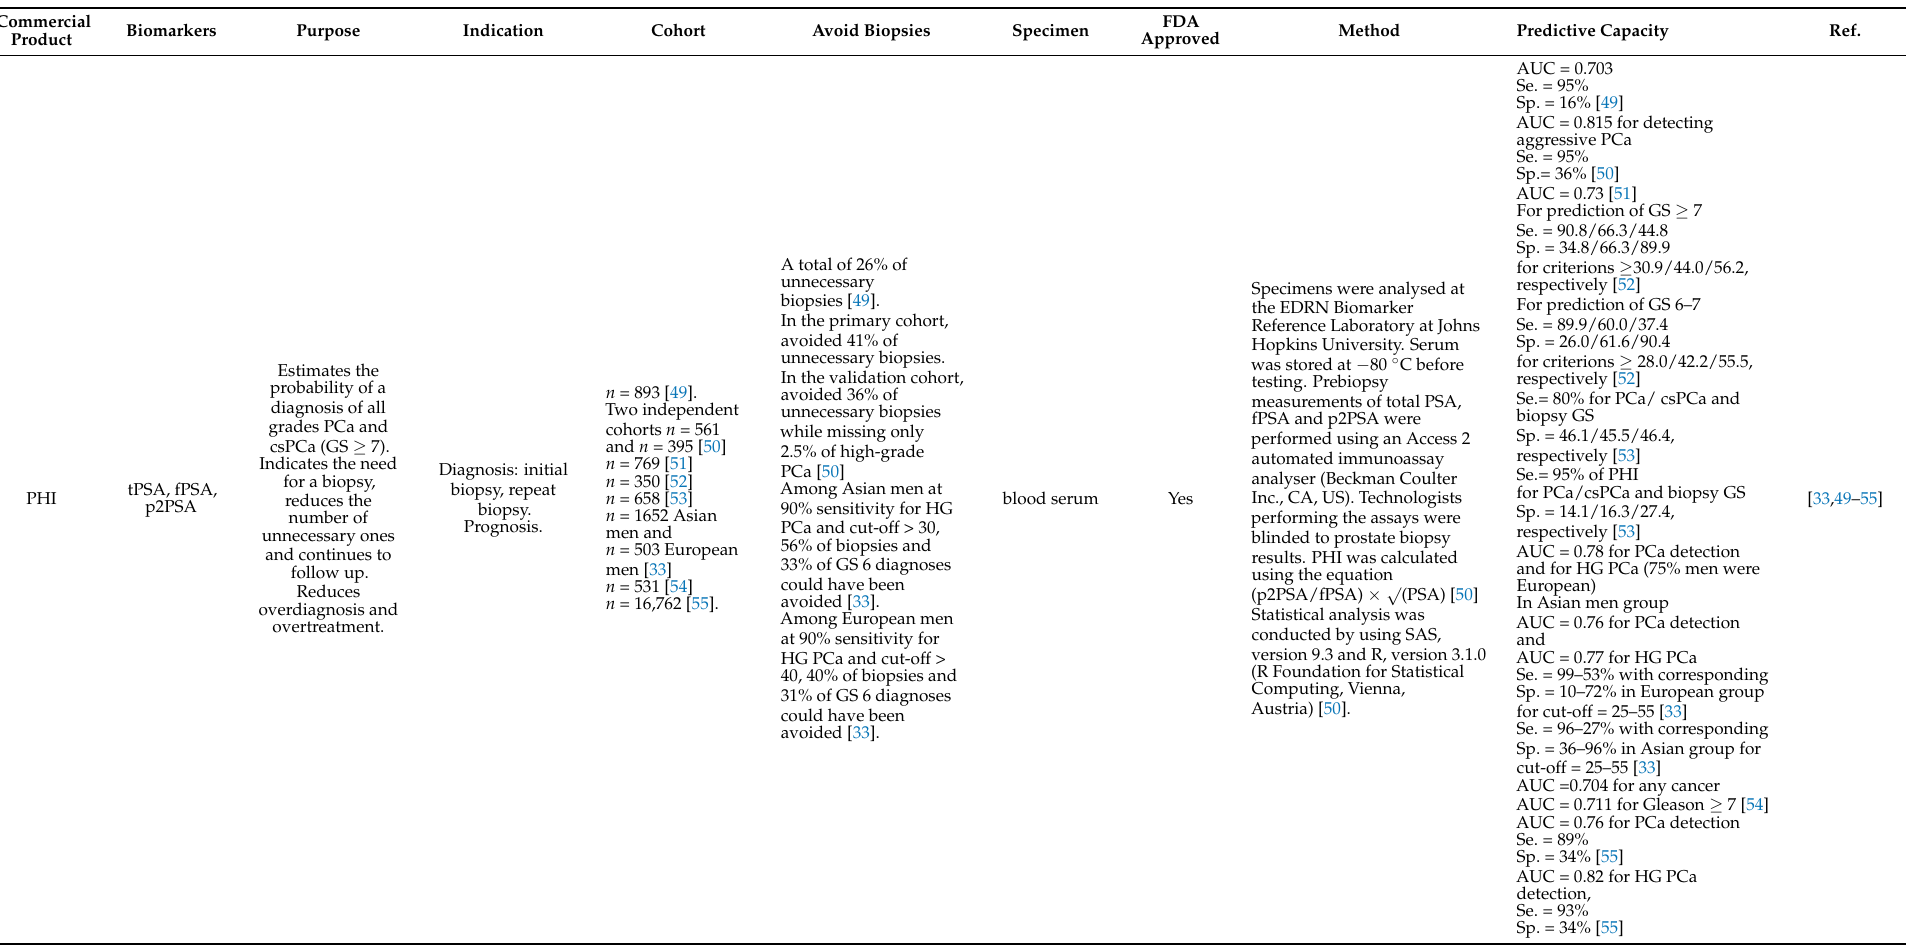
Table 3. Predictive capacity of prostate cancer prebiopsy